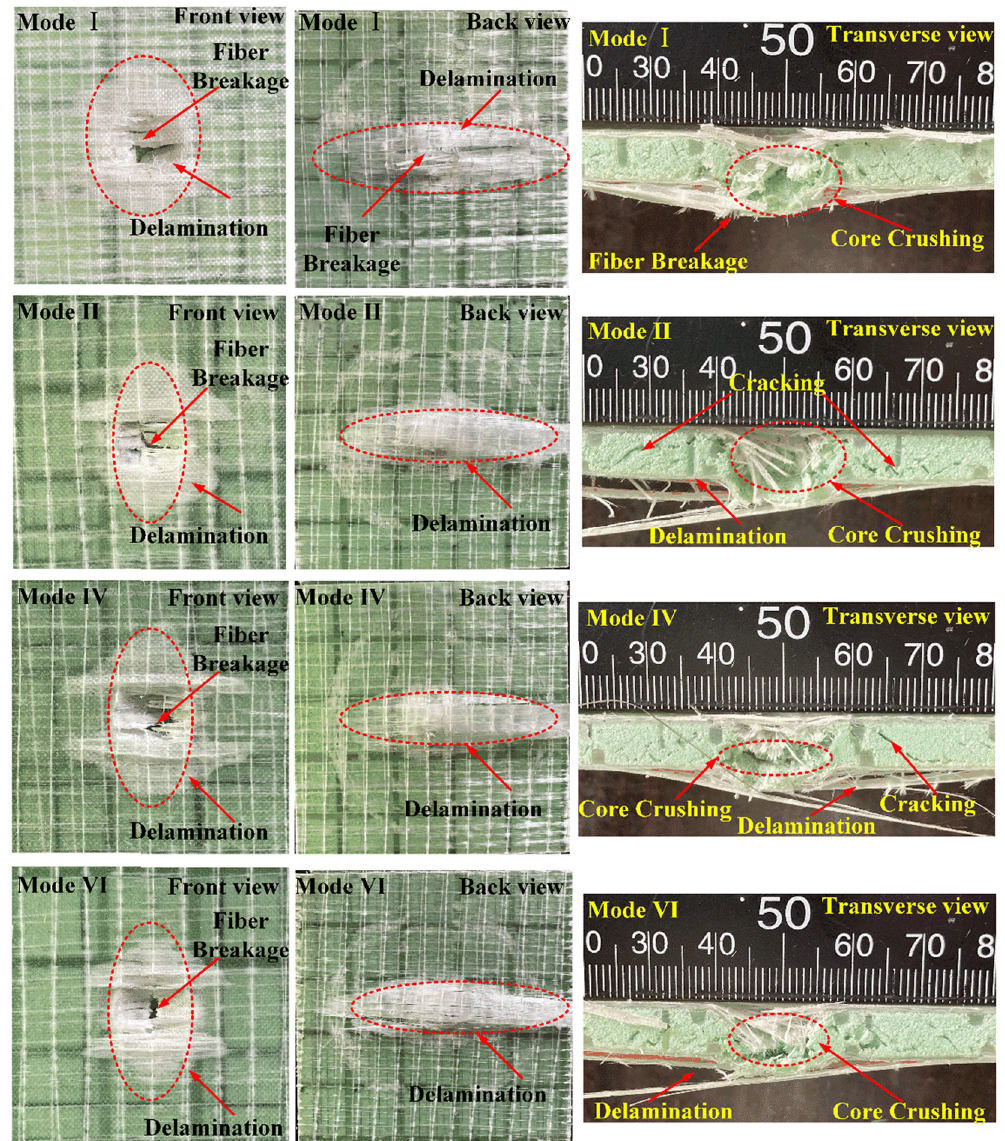
Figure 4: Typical damage morphology in the failure specimens. The center 60 mm 2 × 60 mm 2 region is shown for the pictures in a front view, the whole rear surface is presented for the pictures in a back view, and the center width of 60 mm along the long axis of the delamination region is revealed for the pictures in a transverse